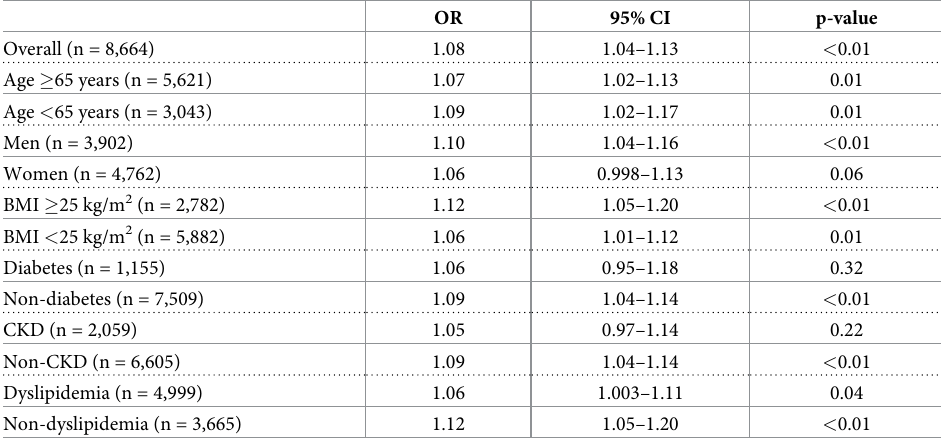
Table 4. Adjusted odds ratios for non-attainment of optimal blood pressure level of +1 mg/dL of uric acid concentration.